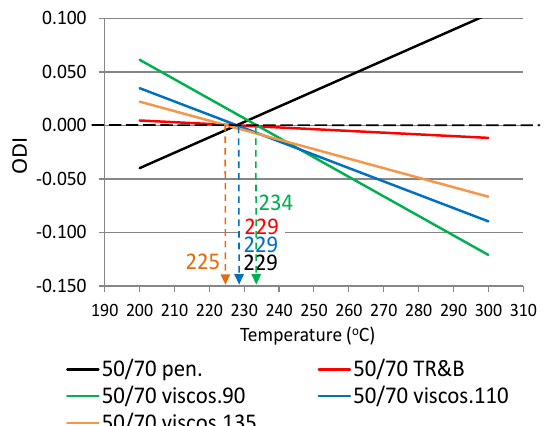
Figure 2. Comparison of sensitivity to overheating A (ODI) of non-modified and modified bitumens, based on an example graph for Overheating Degradation Index of penetration (ODI pen. ).